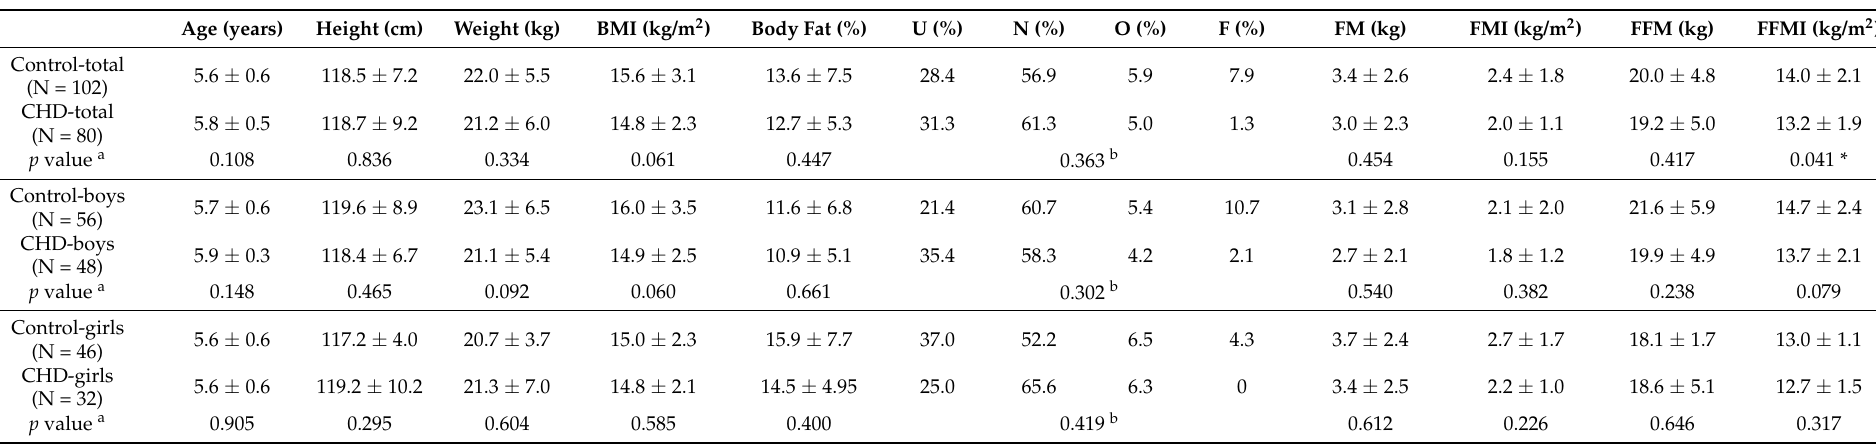
Table 1. Baseline characteristics of all recruited preschool